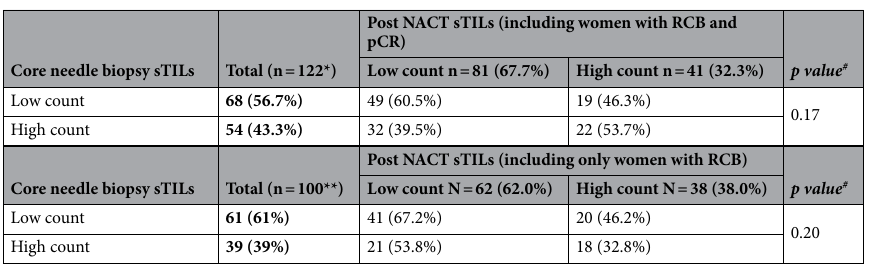
The predominant association of PD-L1 expression with non-luminal breast carcinomas (27 out of 36, or 75%) and high histological grade (51 out of 65, or 78%) found in our patients is in accordance with previous reports 16,40,42,43 . PD-L1 expression is particularly frequent in triple negative breast carcinomas, a subtype that most benefits from immunotherapy. Interestingly, among our cases of hormone positive carcinomas PD-L1 was expressed in about half of the cases (48 out of 94, or 52%). This figure is higher than the frequency reported